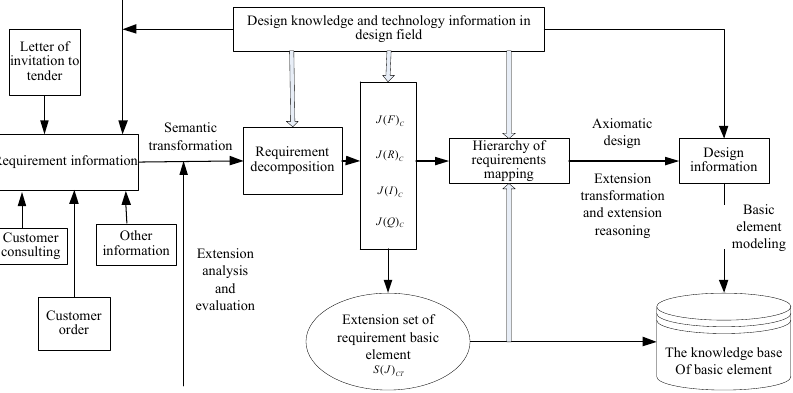
Figure 1. The extension process model of requirement analysis of complex product conceptual de-